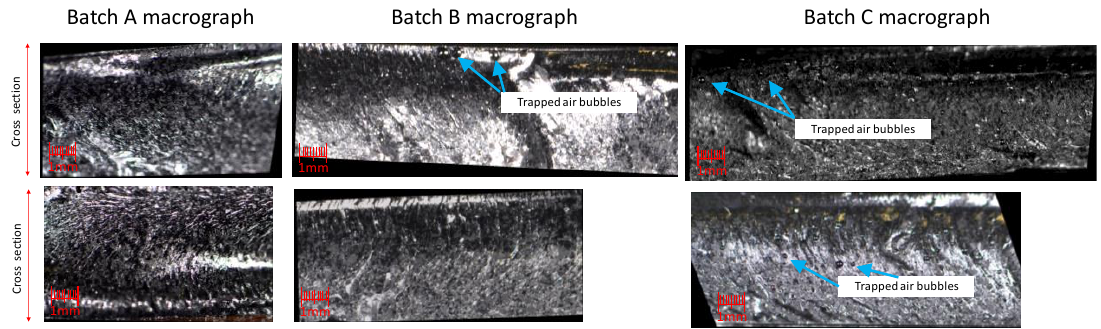
Figure 8. Macrographs of the cross-section of the Batch A (on the left ), Batch B (on the center ), and Batch C (on the right ).